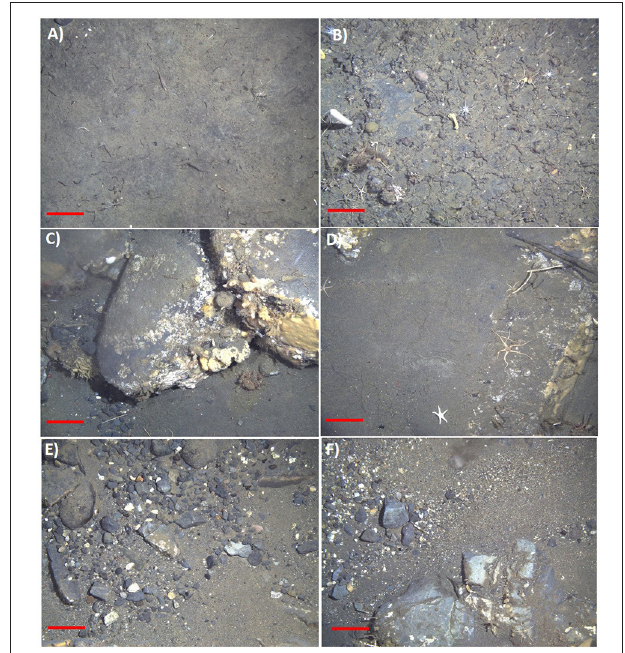
FIGURE 2 | Examples of in-situ SUCS images showing different substrate classifications. (A) Mud dominated, (B) gravel and small pebbles above exposed bedrock, (C) boulders/dropstones, (D) sandy bottom with some exposed boulders, (E) gravel and small pebbles, and (F) mixture of sand, gravel, pebbles, and cobbles. Scale bars represent